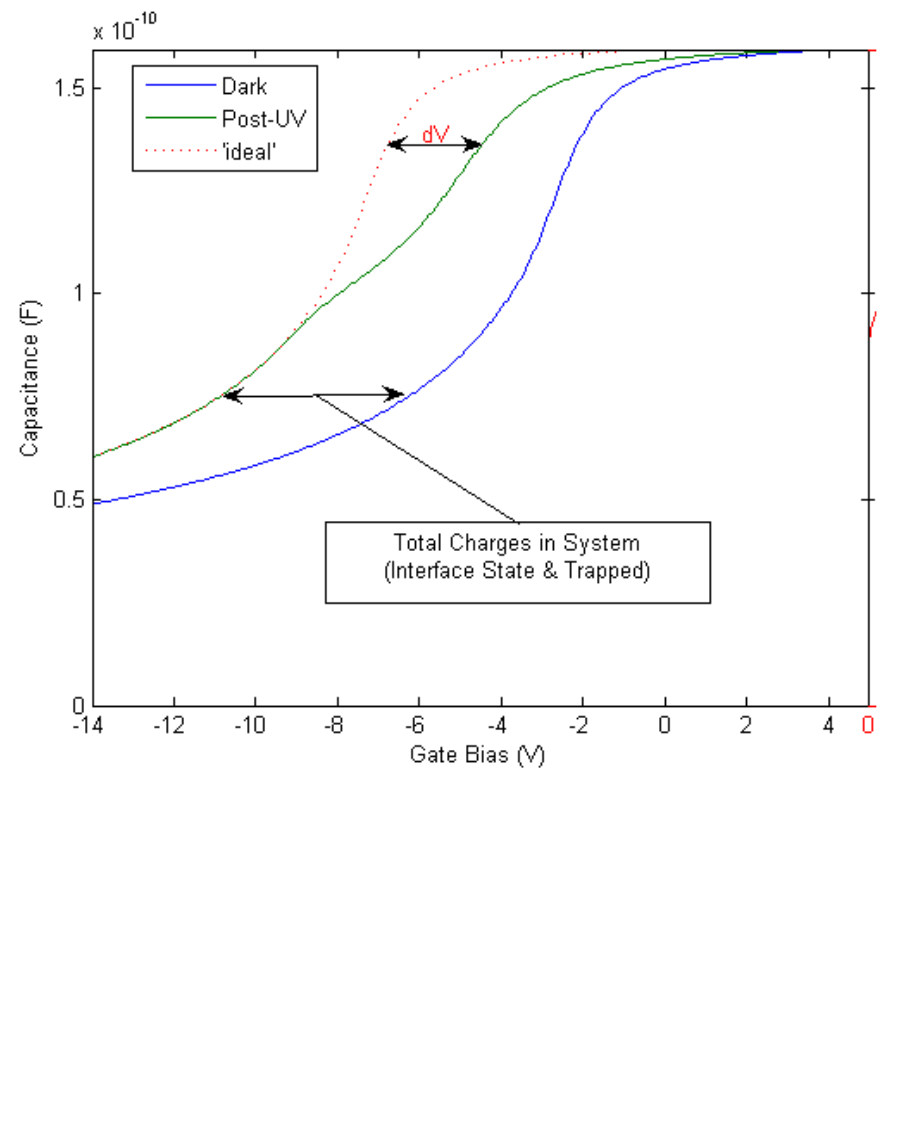
Figure 8. Modified Terman method for measurement of the interface state density using UV illumination [85]. Reprinted with permission from reference 85. Copyright (2009) by the American Institute of